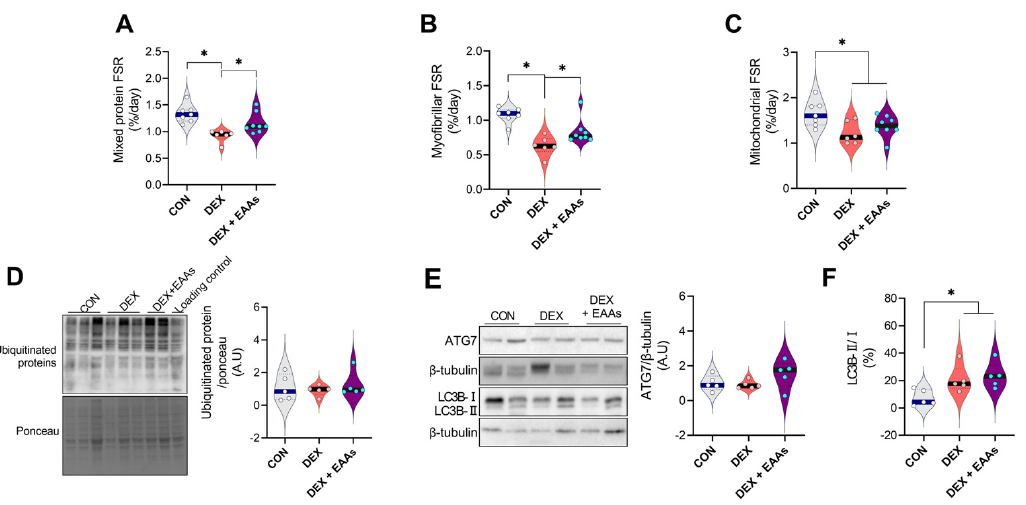
Figure 2. The EAA-enriched diet promotes myofibrillar protein synthesis rate but not the protein degradation pathway by DEX treatment in GA muscle. ( A ) Rates of integrated mixed muscle protein synthesis rate ( n = 6–8). ( B ) Rates of myofibrillar protein synthesis rate ( n = 6–8). ( C ) Mitochondrial protein synthesis rate ( n = 6–8). ( D ) Relative protein expression levels of ubiquitinated proteins (expression levels were normalized by total proteins, n = 5). ( E ) Relative protein expression levels of ATG7 and ( F ) the ratio of LC3B-II/I ( n = 5). * Significant difference between labeled groups (* p < 0.05). CON, control; DEX, dexamethasone; EAAs, essential amino acids; GA, gastrocnemius; FSR, fractional protein synthetic rate; ATG7, autophagy related7; LC3B, microtubule-associated protein II-light chain 3.